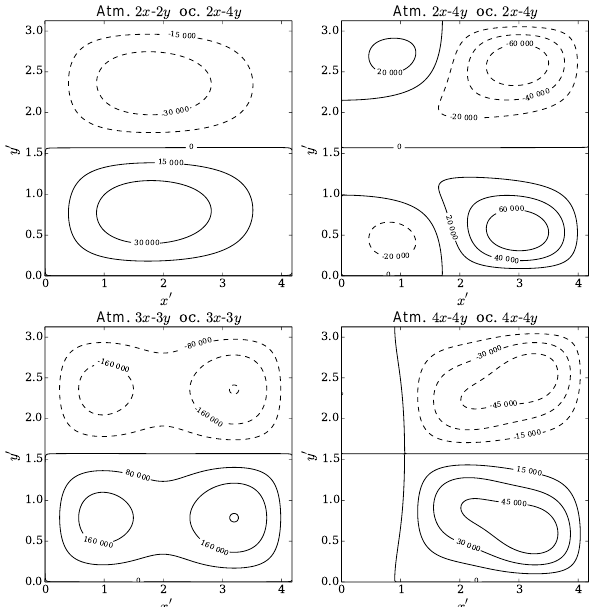
ψ a Figure 11. Climatologies for the oceanic streamfunction field ψ o g (m 2 s − 1 ) presented on the non-dimensional model domain, as ob- tained using 92179.6 years of model integration.